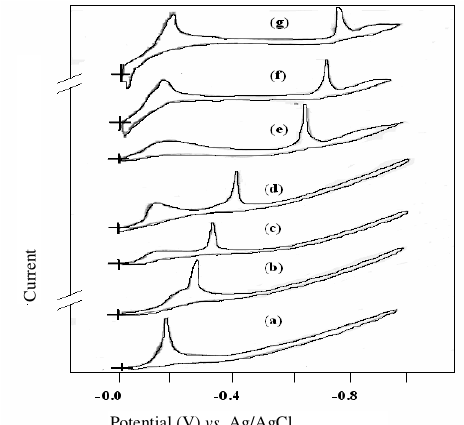
Figure 3. Cyclic voltammograms of 1 (3.5 x 10 -4 M) in buffers (ionic strength = 0.05 M) of pH (a) 2.56, (b) 4.02, (c) 5.93, (d) 7.40, (e) 8.78, (f) 9.62 and (g)